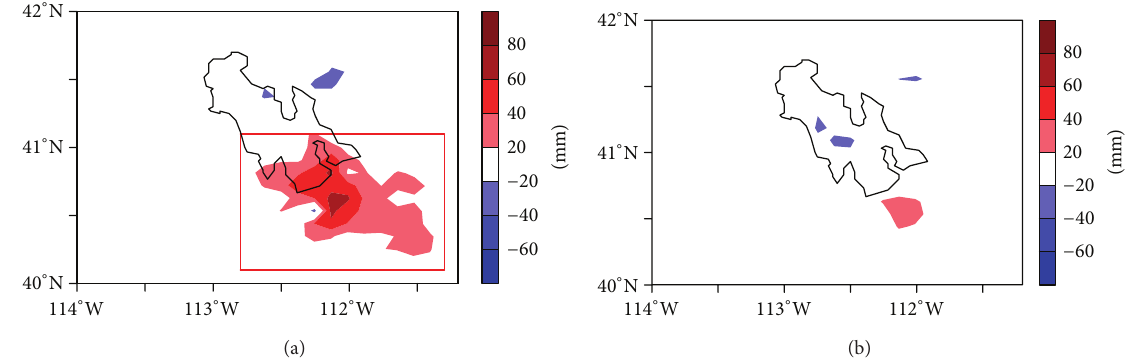
Figure 5: Simulated precipitation differences between SL and NL experiments and between SL and FL experiments from October 2001 to April 2002.